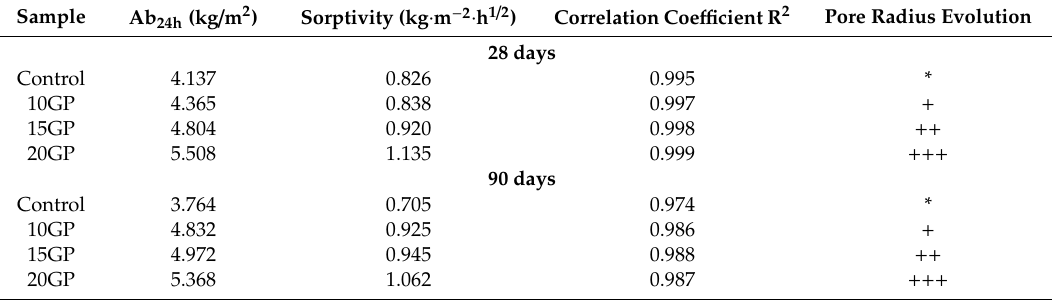
Table 6. Evolution of water capillary absorption and sorptivity; *: average pore radius of the control; + , ++ & +++ : increasing of the average pore radius compared to the control; Ab in 24